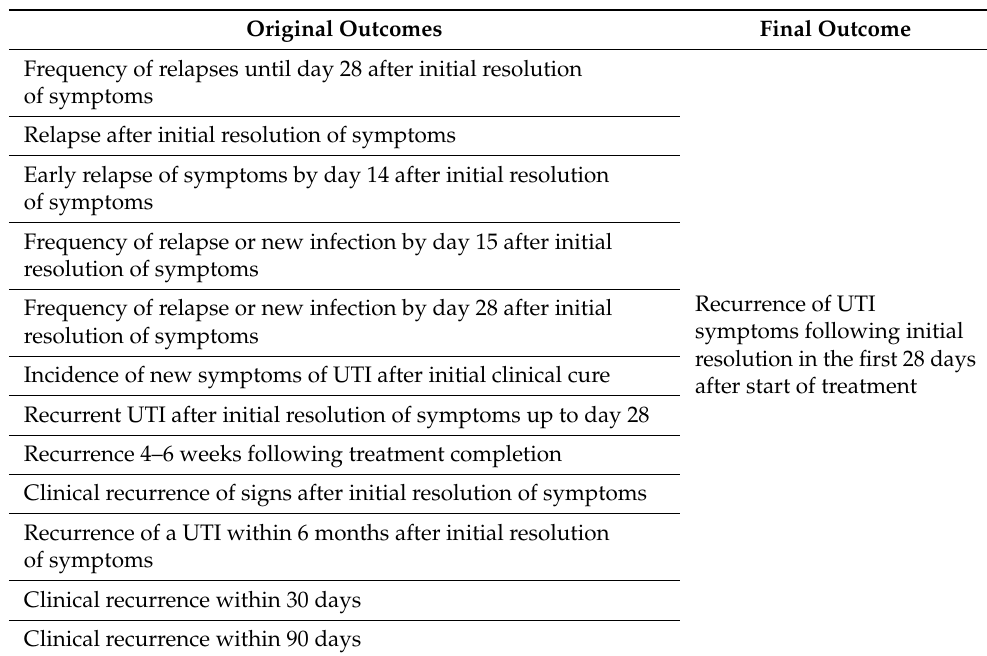
Table 2. Outcomes combined to create outcome